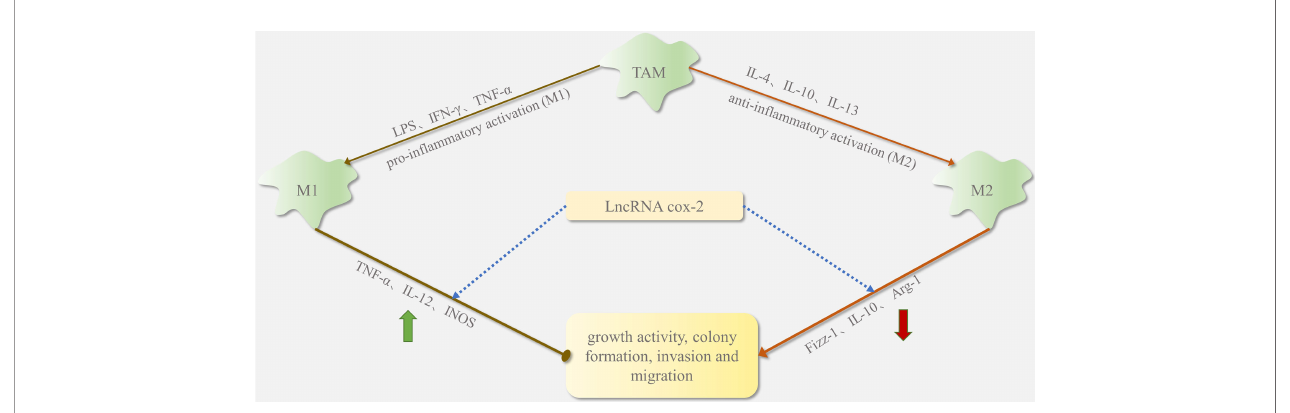
FIGURE 3 | The function of lncRNA cox-2 in TAM phenotype